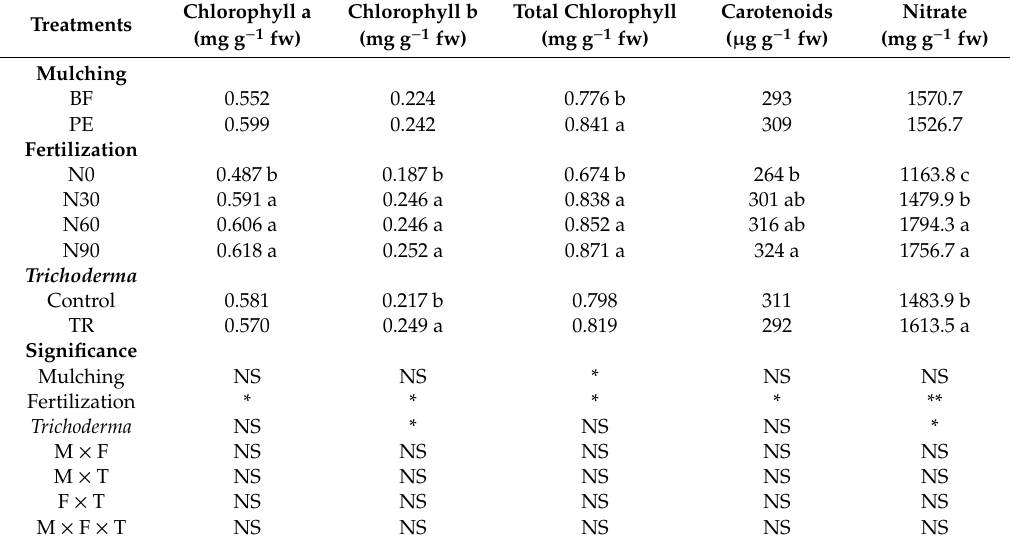
Table 4. Chlorophyll (a, b, and total), carotenoids, and nitrate content in relation to mulching cover films (brown photoselective film—YF and black polyethylene—PE), Trichoderma application (untreated—Control and treated—TR) and N fertilization rates (N0 = 0, N30 = 30, N60 = 60, and N90 = 90 kg ha − 1